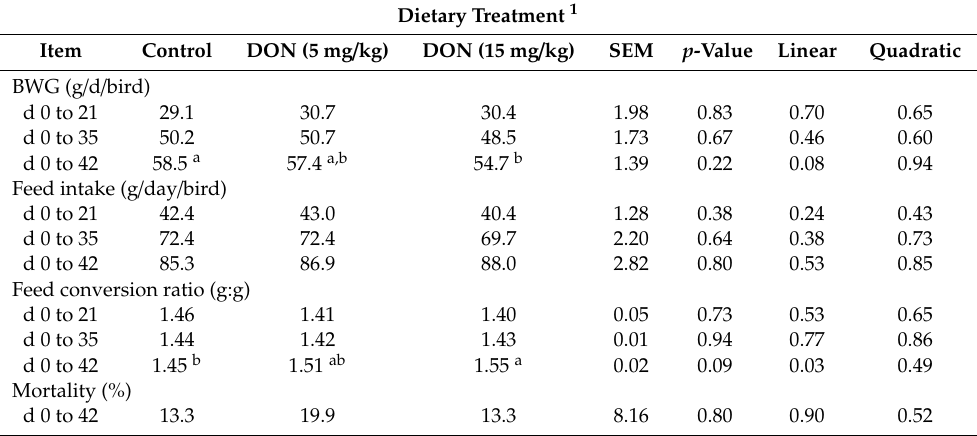
Table 2. E ff ects of DON-contaminated feed (5 and 15 mg / kg) on growth performance of broiler chickens. Dietary Treatment 1